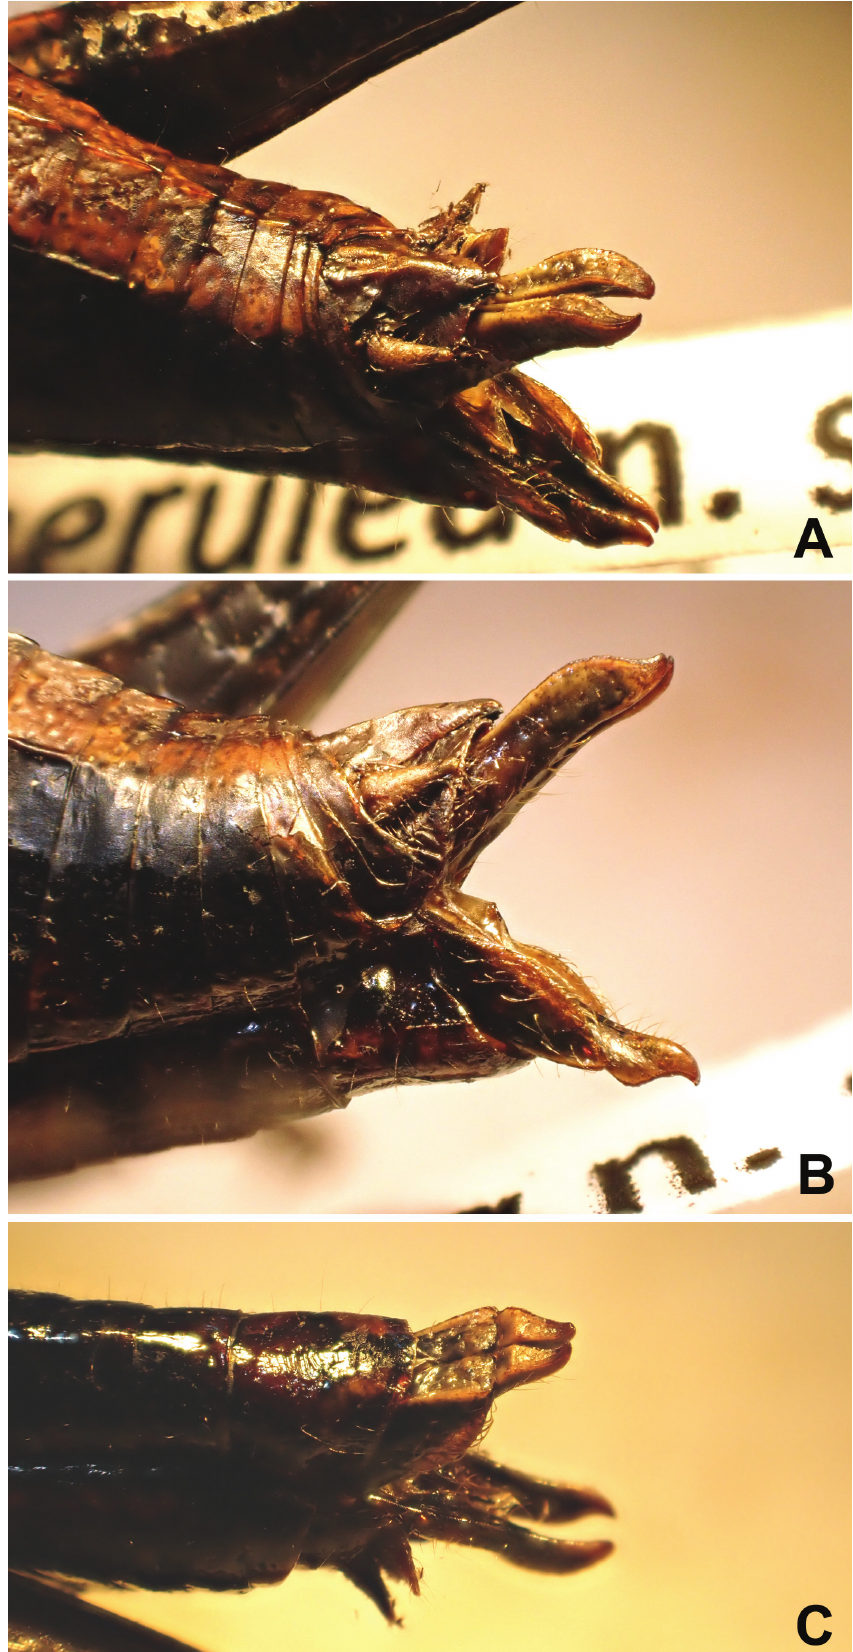
Fig. 7. Abdominal apex of female Burttia caerulea sp. nov. A. semilateral; B. lateral; C. semilateral